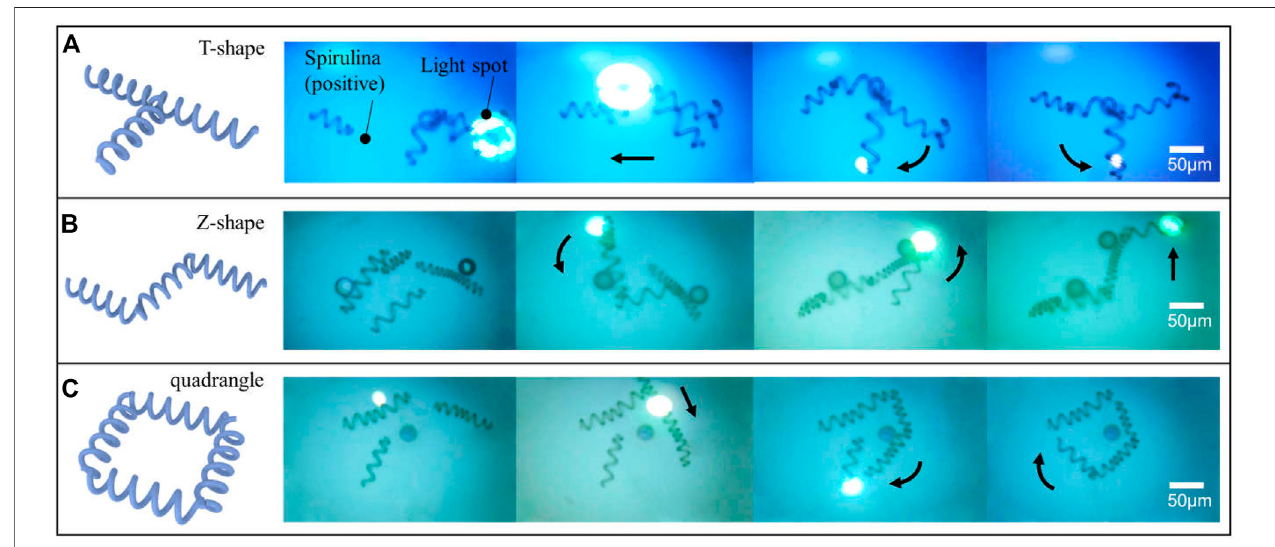
FIGURE 8 | Flexible assembling micro-spiral into the different shapes of microstructure: (A) T-shape, (B) Z-shape, and (C) quadrangle shape.